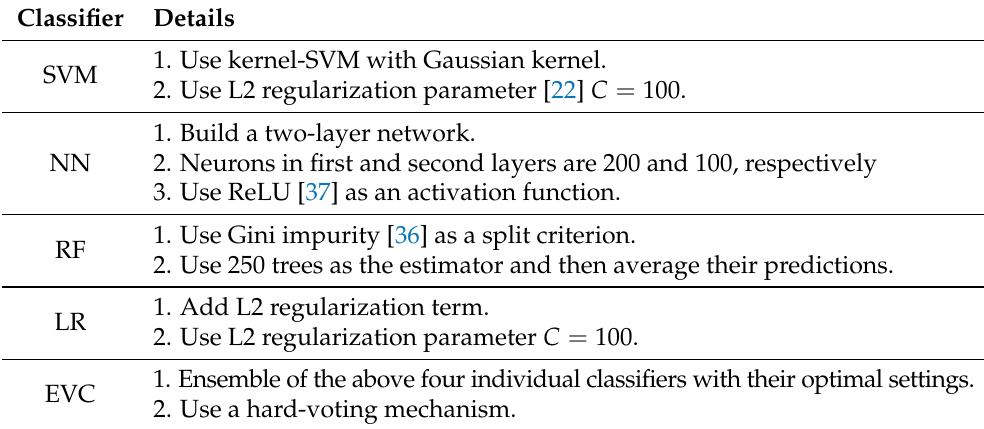
Table 2. Implementation details of the